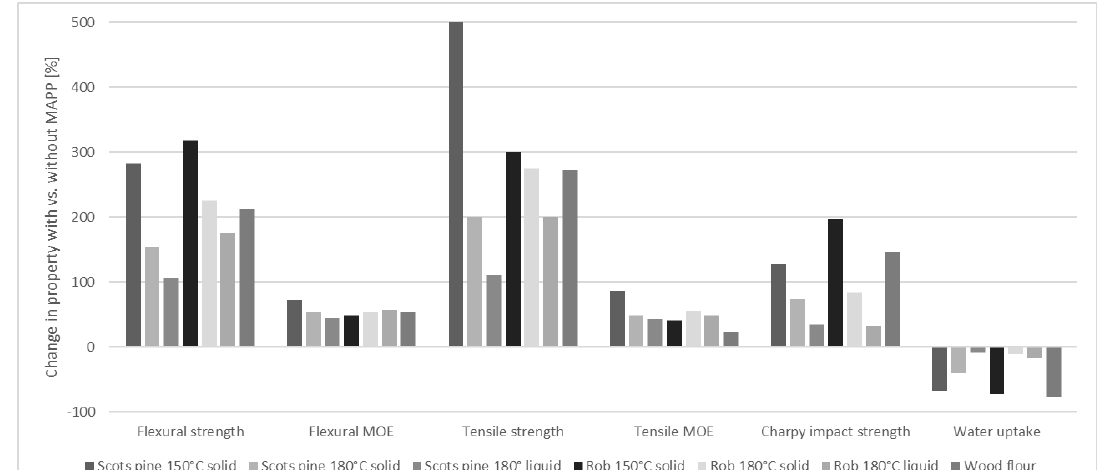
Figure 9. Improvement in mechanical properties and water uptake of WPC due to the use of MAPP (reference: corresponding formulations without MAPP). Solid: MAPP applied as pellets; liquid: MAPP applied as emulsion; rob: Robinia. Temperatures correspond to defibration temperatures during thermomechanical pulping.